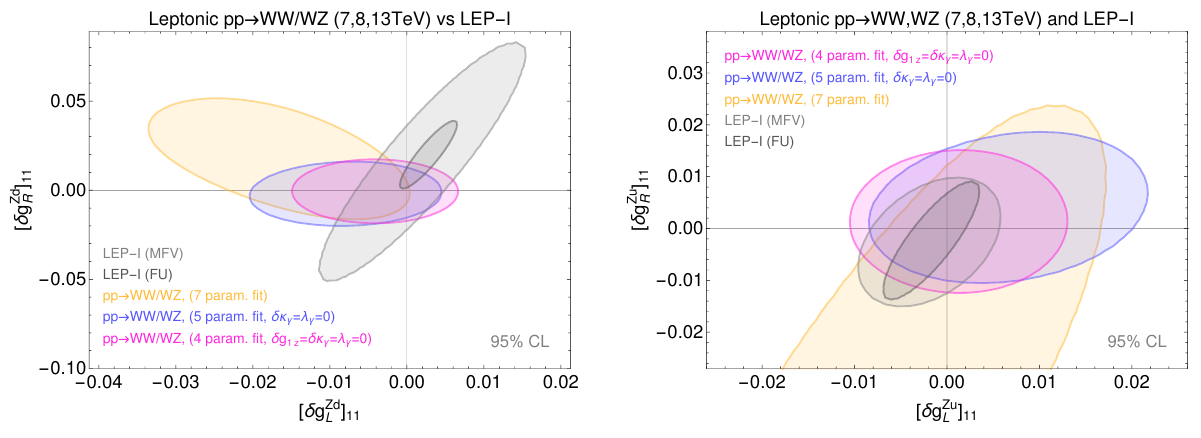
Figure 3 . 95% CL regions for the anomalous couplings between the light quarks and the electroweak bosons. In light (dark) gray, the LEP-1 constraints assuming MFV (FU). In yellow, the diboson bounds after pro(cid:12)ling over the remaining (cid:12)ve parameters. In blue (pink) the same but